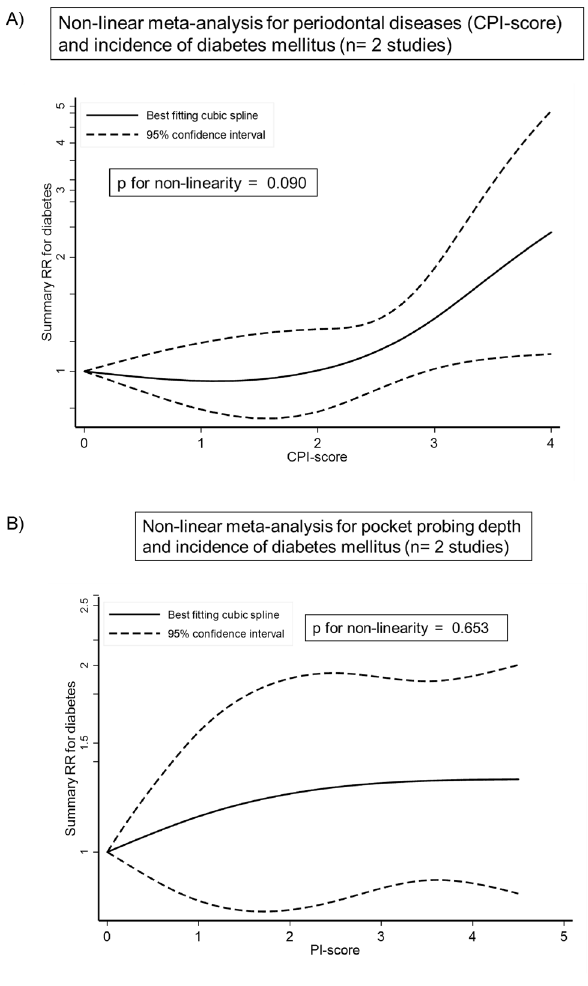
Figure 2. Non-linear dose–response meta-analysis for periodontal disease, defined as ( A ) CPI-score and ( B ) defined as PPD, and incidence of diabetes